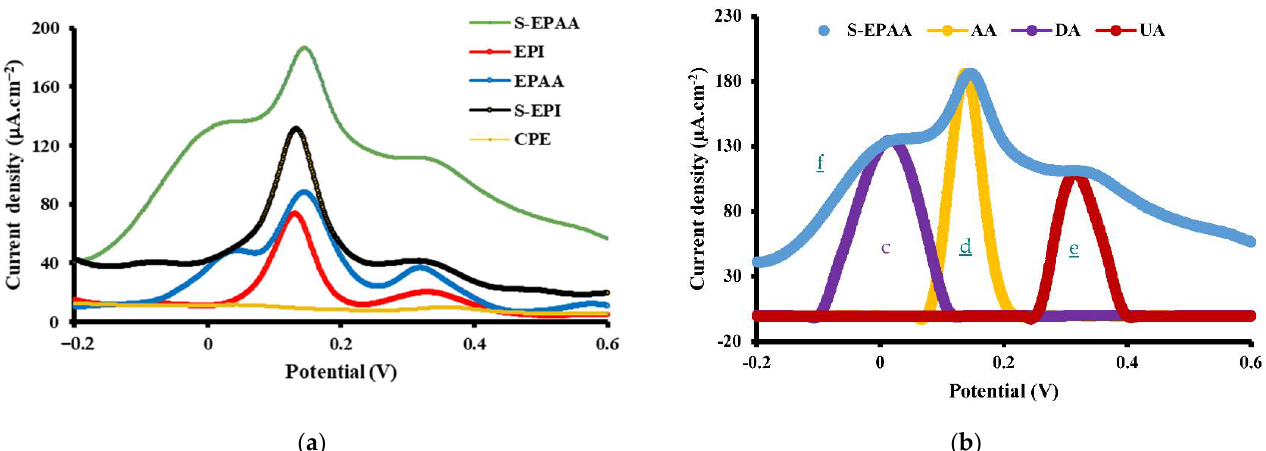
Figure 7. ( a ) DPV obtained with bare CPE, EPAA, EPI, S-EPAA and S-EPI-modified electrodes for a tertiary mixture of 20 μM AA/DA/UA in 0.1 M PBS and ( b ) DPV of 20 μM DA (c), 20 μM AA (d), 20 μM UA (e) and 20 μM AA/DA/UA (f) for the S-EPAA-modified CPE in 0.1 M PBS.